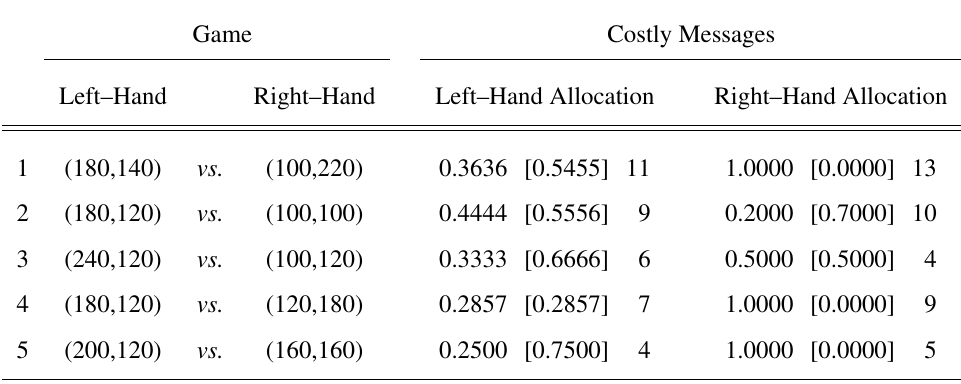
Table 4. Approval [Disapproval] rates of the recipient in the five dictator games using costly messages. The total number of messages being paid for is presented to the right of the disapproval rates. Game Costly